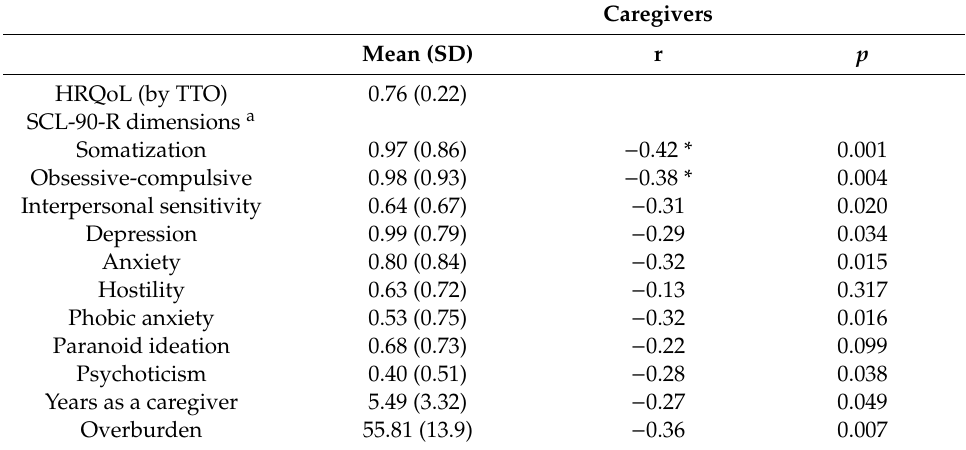
Table 4. Bivariate correlations between health-related quality of life and the main study